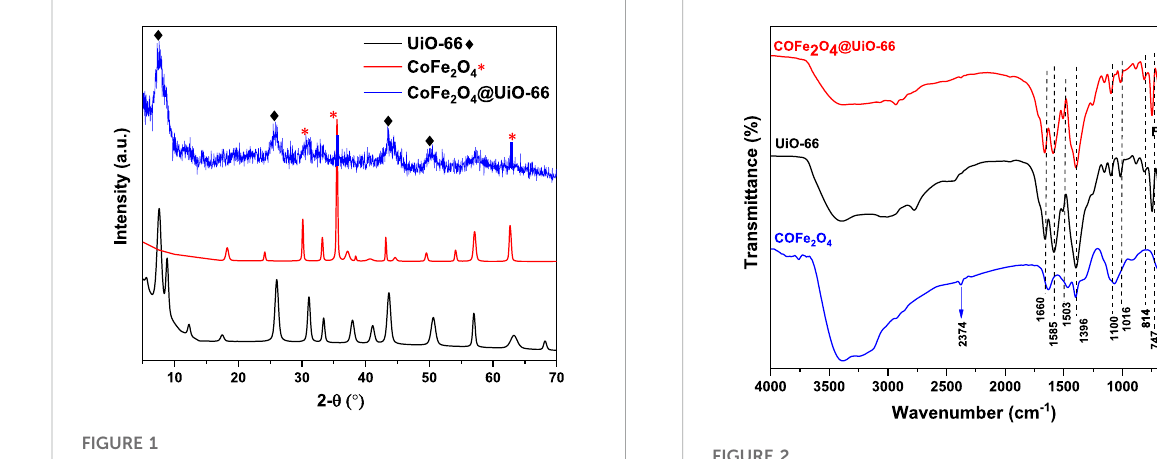
FIGURE 1 XRD patterns of UiO-66, CoFe 2 O 4 , and CoFe 2 O 4 @UiO- 66 composite.